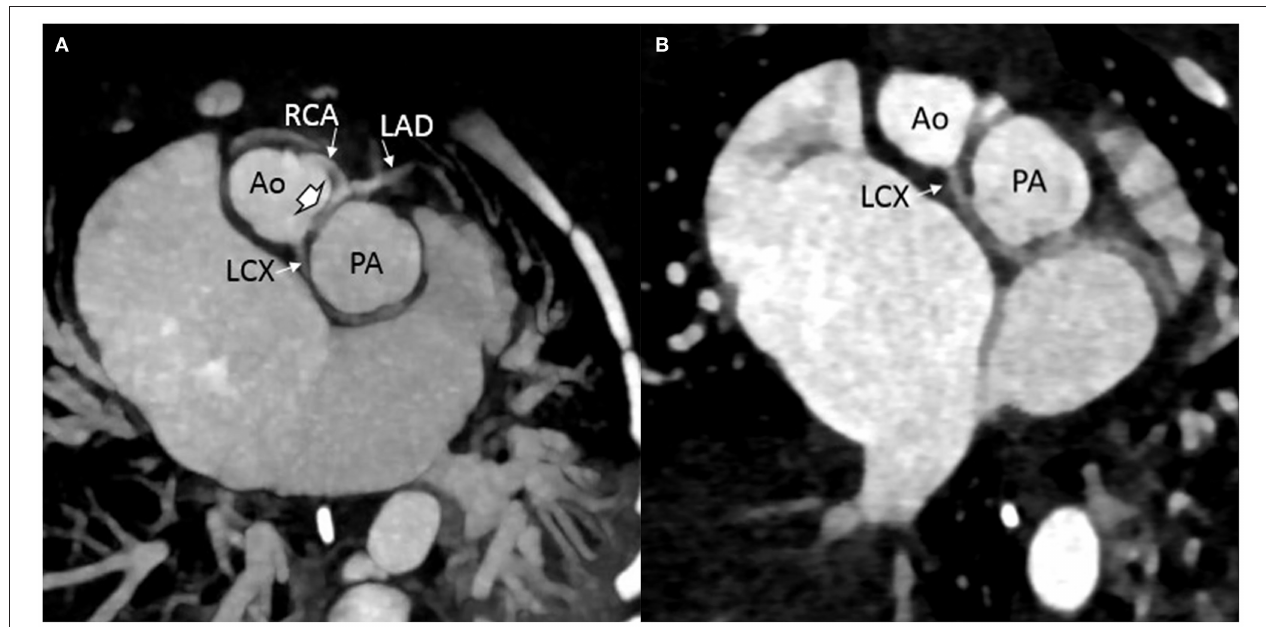
FIGURE 2 | Computed tomography images showing preoperative arrangement of the coronary artery pattern: (A) intramural course (solid arrowhead) of the main segment of the coronary artery that divides into the right coronary artery (RCA) and the left anterior descending (LAD) from the posterior sinus (Sinus 1); left circumflex coronary artery (LCX) seen arising from the same sinus. (B) LCX seen arising from the Sinus 1 with a retro-pulmonary